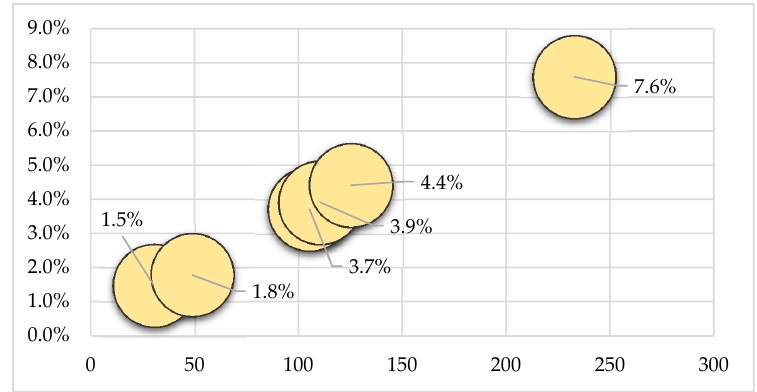
Figure 13. Incomes of top 500 world new energy enterprises in 2011–2016 (Unit: billion yuan) [74].